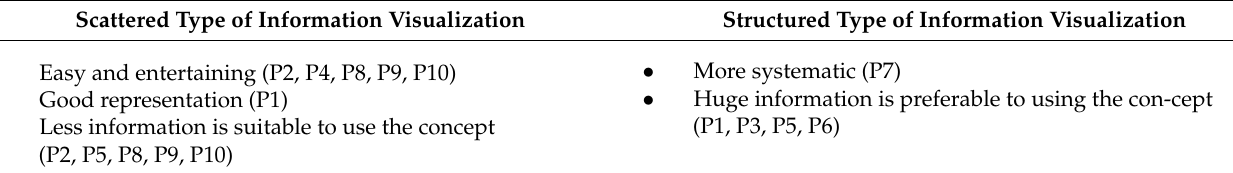
Table 5. Preferences of information visualization by